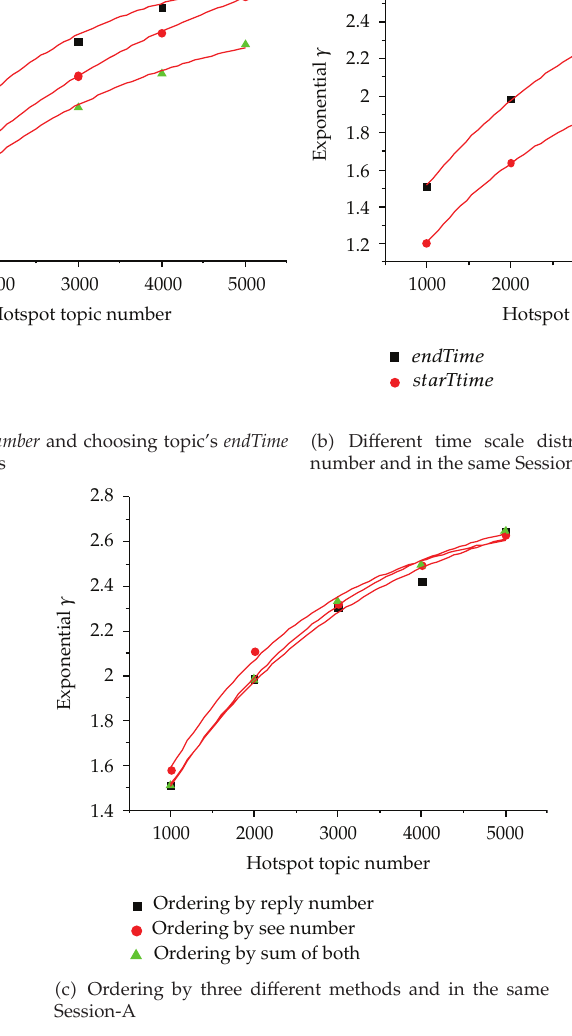
Figure 2: Relationship between hotspot number N and power exponent γ